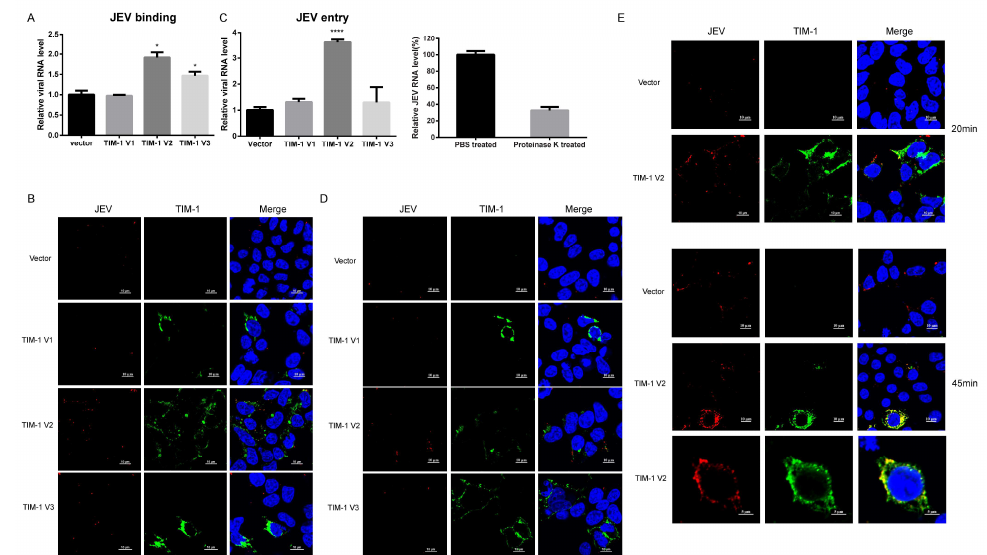
Figure 4. TIM-1 V2 enhances JEV attachment and entry. 293T cells were transfected with an empty vector or a plasmid encoding TIM-1 variant for 24 h. ( A ) They were incubated with JEV (MOI = 5) at 4 ◦ C for 30 min, and washed with PBS three times. Total RNA was extracted and used for quantification of JEV RNA by qRT-PCR. Data are presented as mean ± SD from three independent experiments using t-test. * p < 0.05; ( B ) cells were incubated with JEV NJ2008 (MOI of 20) at 4 ◦ C for 30 min and fixed followed by confocal microscopy. Scale bars, 10 µ m; ( C ) cells were challenged with JEV NJ2008 (MOI = 5) at 4 ◦ C for 1 h. They were then washed with PBS (or treated with proteinase K to examine the efficiency of removing JEV virions on the cell membrane) to remove unbound JEV particles and then transferred to 37 ◦ C for 15 min to allow virus entry. Total RNA was extracted and used for quantification of JEV RNA by qRT-PCR. Data are presented as mean ± SD from three independent experiments using t-test. **** p < 0.0001; ( D ) cells were incubated with JEV NJ2008 (MOI of 10) at 4 ◦ C for 1 h. Then, they were transferred to 37 ◦ C for 15 min, treated with proteinase K (1 mg/mL) and fixed with 4% PBS-PFA. They were stained with anti-E monoclonal antibody and anti-TIM-1 polyclonal antibody. Scale bars, 10 µ m; ( E ) cells were transfected with the indicated plasmids for 24 h, and then incubated with JEV NJ2008 (MOI of 10) at 37 ◦ C for 20 min and 45 min. Cells were fixed and detected by confocal microscopy. Scale bars, 10 µ m or 5 µ